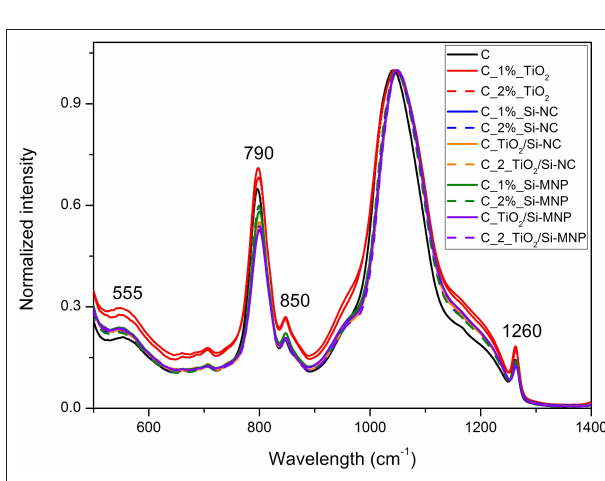
FIGURE 4 | Infrared spectra of all the samples in the range between 500 and 1,400 cm − 1